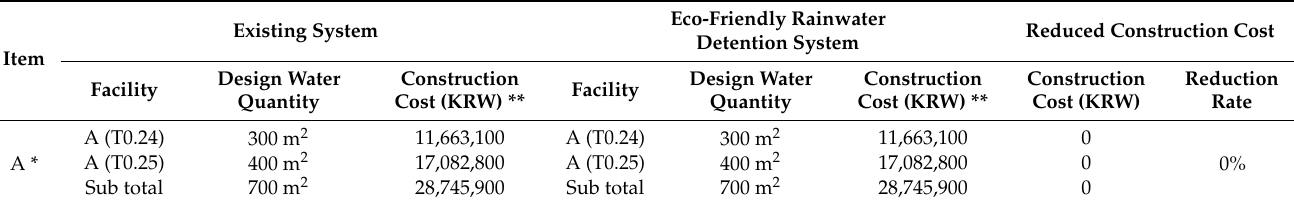
Table 13. Details of the construction